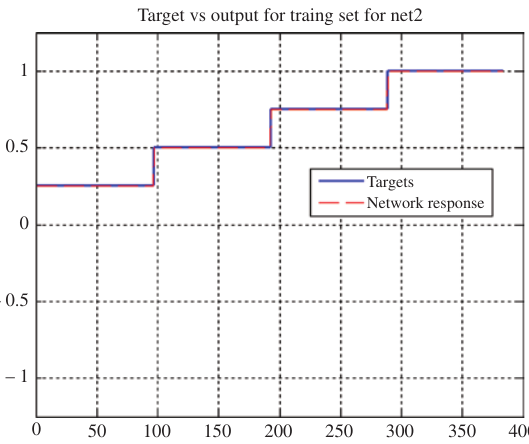
Target vs output for traing set for net2